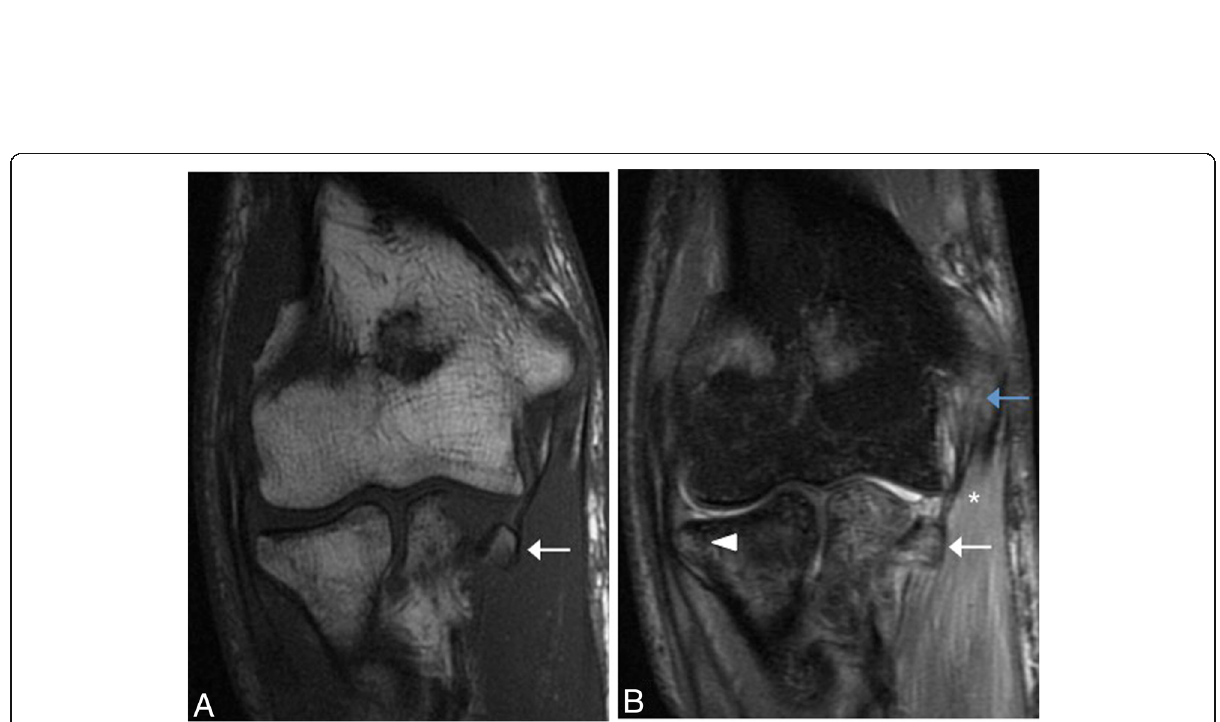
Fig. 15 A 32-yer-old man with pain and medial instability after a fall on the outstretched arm. Coronal T1-weighted MRI ( a ) and coronal FS PD- weighted MRI ( b ) showing an acute avulsion fracture of the anterior bundle of the medial collateral ligament insertion in the sublime tubercle (white arrows), acute partial-thickness proximal tear of anterior bundle of the medial collateral ligament (blue arrow), flexor digitorum superficialis muscle edema (white asterisk), and radial head contusion (white